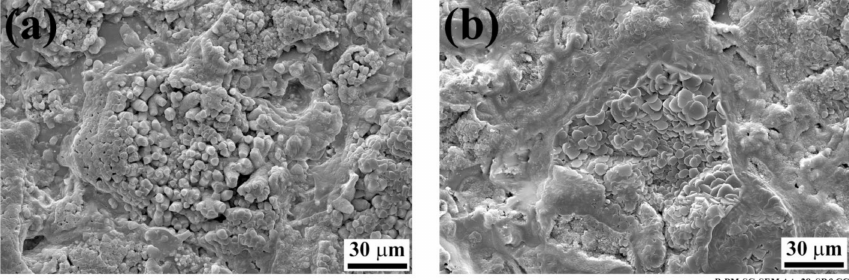
Figure 3. High-magnification SEM images of the aluminum a ff ected areas after 28 days of aging; ( a ) SB and ( b ) CC specimens showing nodular, flake-like structures.